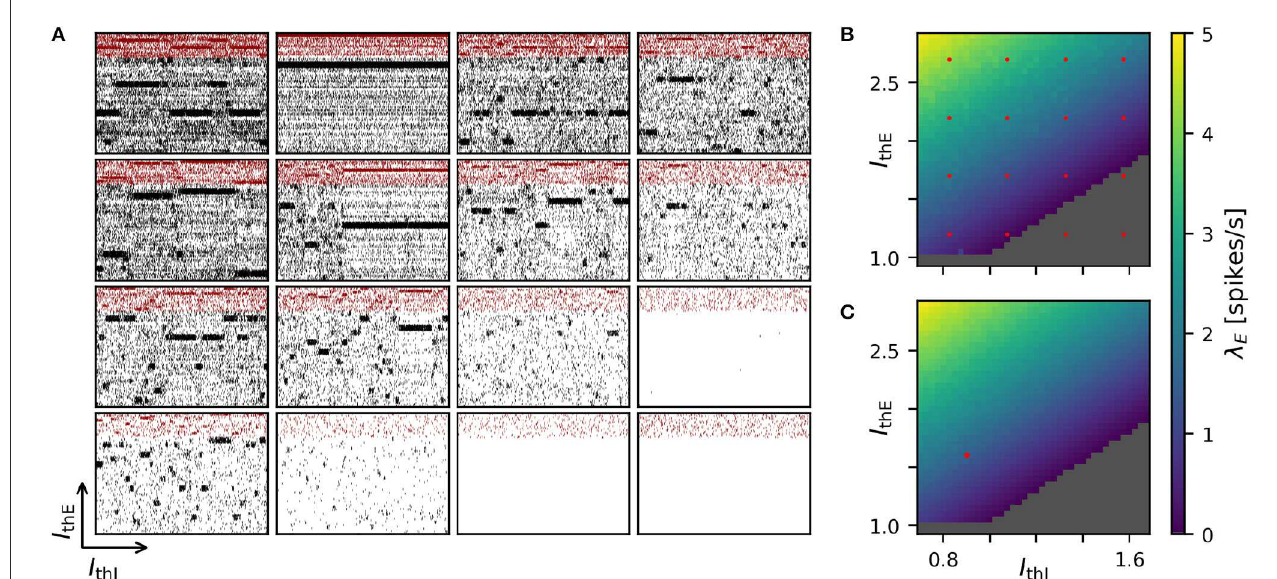
FIGURE5 Two-dimensional parameter grid search with GeNN and NEST. (A) Shown are a subset of 4 × 4 spike raster plots as generated from simulations with NEST. The respective parameter values are indicated by the red point markers in (B) . In each raster, 8% of neurons from each of the 20 clusters are displayed. The network size was N = 25,000 and the clustering parameter was J E + = 2.75 as in Figures 1D, 4. (B) Average spontaneous firing rates of all excitatory neurons in dependence of I thE and I thI across the complete grid of 40 × 40 parameter pairs when simulated with NEST. The run-time for completing the grid search was 29,692 s ( ≈ 8h: 15min). (C) Same as in (B) for the simulation with GeNN in batch mode (batch size 40). The red point marker indicates the parameter combination used for the spike raster plot in Figure 1D. The required run-time was 2,809 s ( ≈ 47min). The dependence of wall-clock time on the average firing rate is analyzed for NEST and GeNN in Supplementary Figure